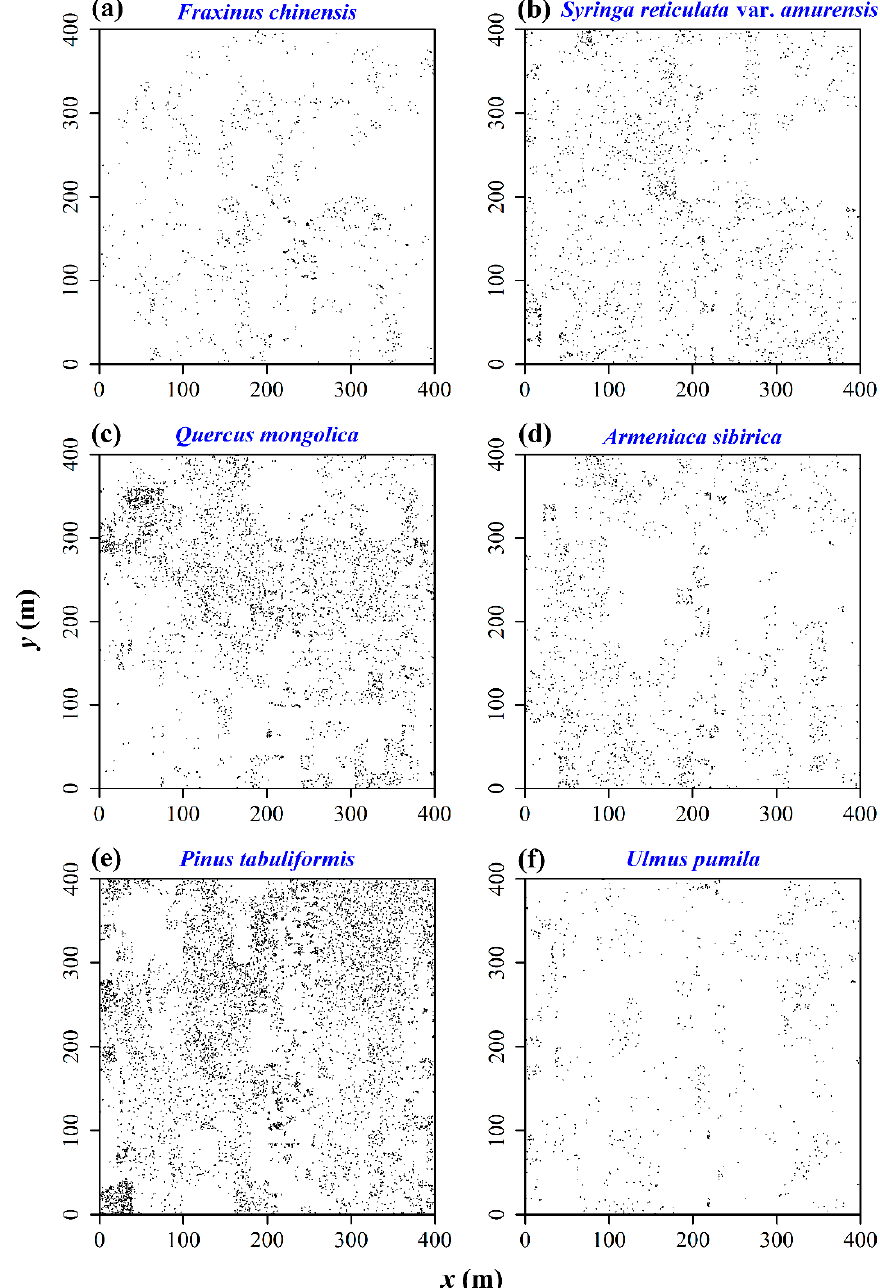
Figure 1. Spatial distributions of six dominant tree species in the study region of [0, 400] × [0, 400] (unit: m). ( a ) F. chinensis ; ( b ) S. reticulata var. amurensis ; ( c ) Q. mongolica ; ( d ) A. sibirica ; ( e ) P. tabuliformis ; ( f ) U. pumila .